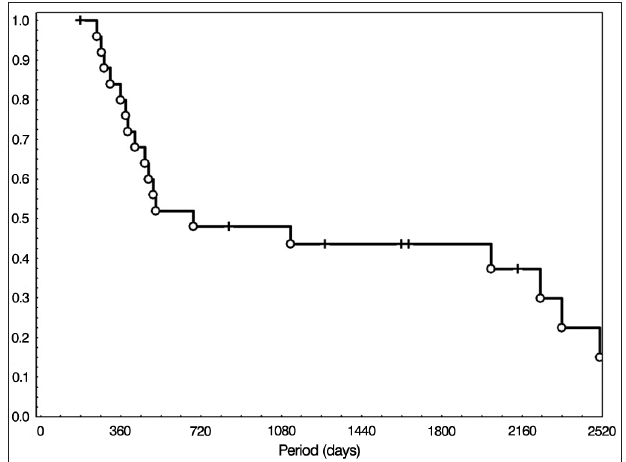
Figure 2. Overall survival of the patients treated with surgery followed by radiotherapy.